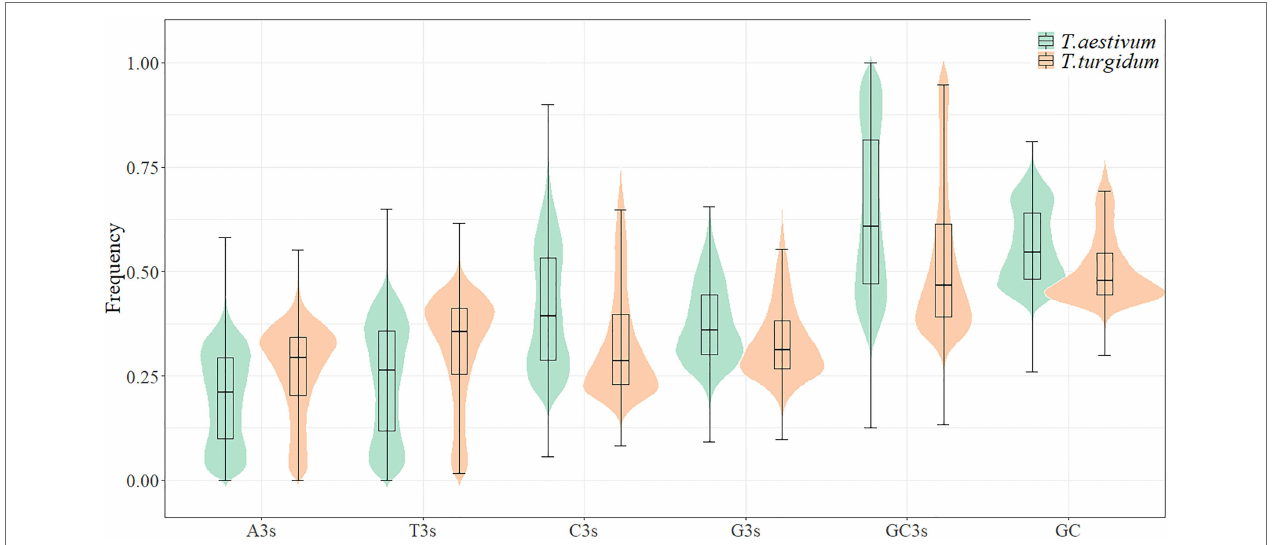
FIGURE 1 | Comparison of base composition between Triticum aestivum and Triticum turgidum